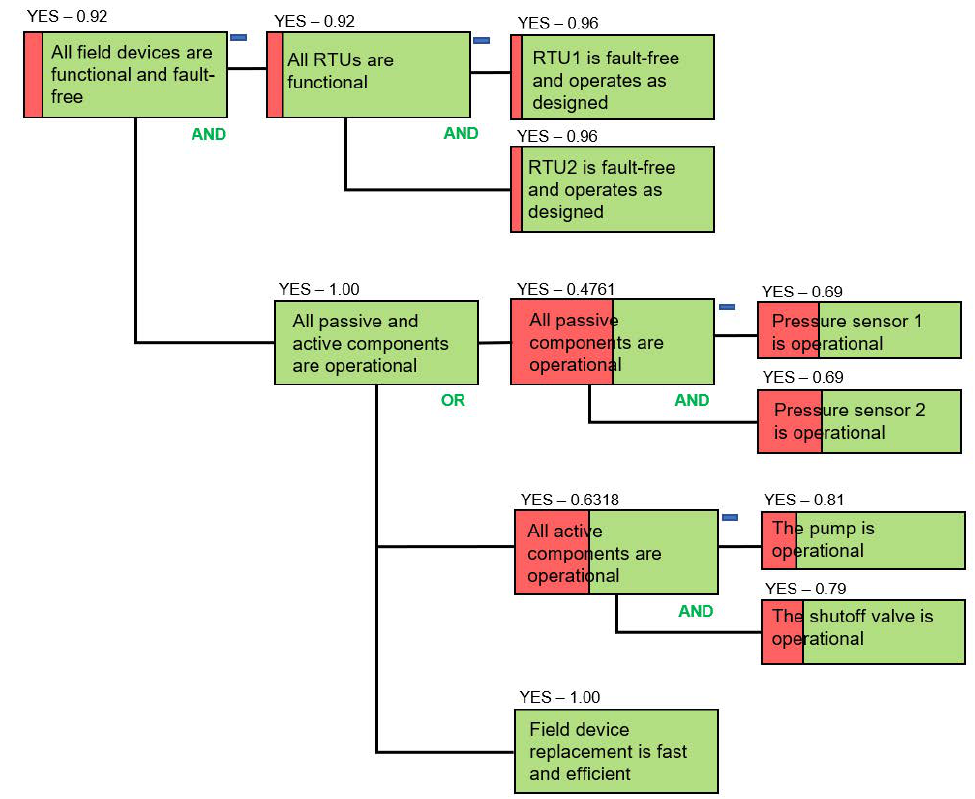
Figure 9. Introducing Field Device Replacement as a